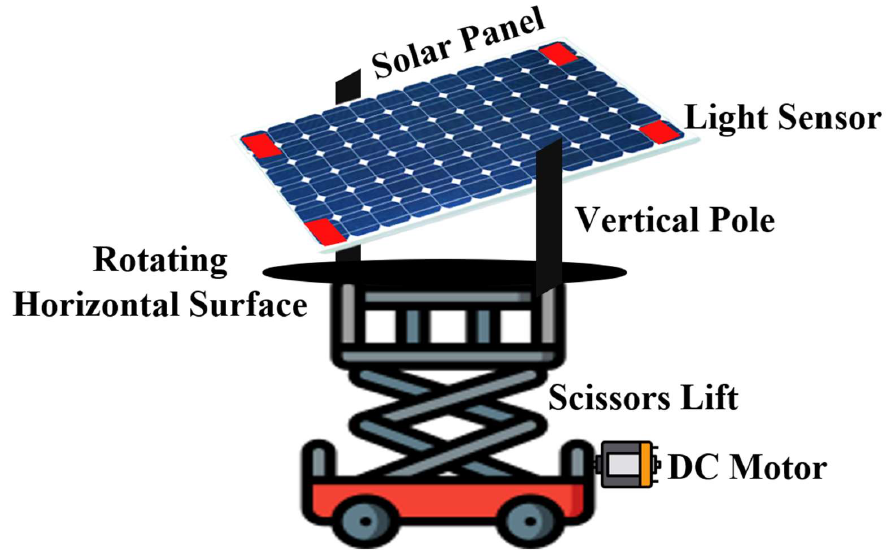
Figure 5. Hybrid Solar Tracking System.